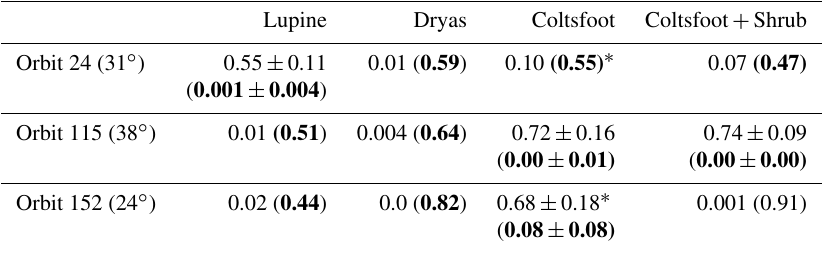
Table 6. R 2 , p value and standard deviation ( R 2 ± SD and p value ± SD in bold) results from linear regression analysis between SD and CPD obtained by vegetation classes and by orbits. The confidence interval was measured using the “bootstrap with replacement” resampling technique ( N bootstrap = 1000). The standard deviation of R 2 and the p value obtained by the technique are indicated in the results whose variance is explained to more than